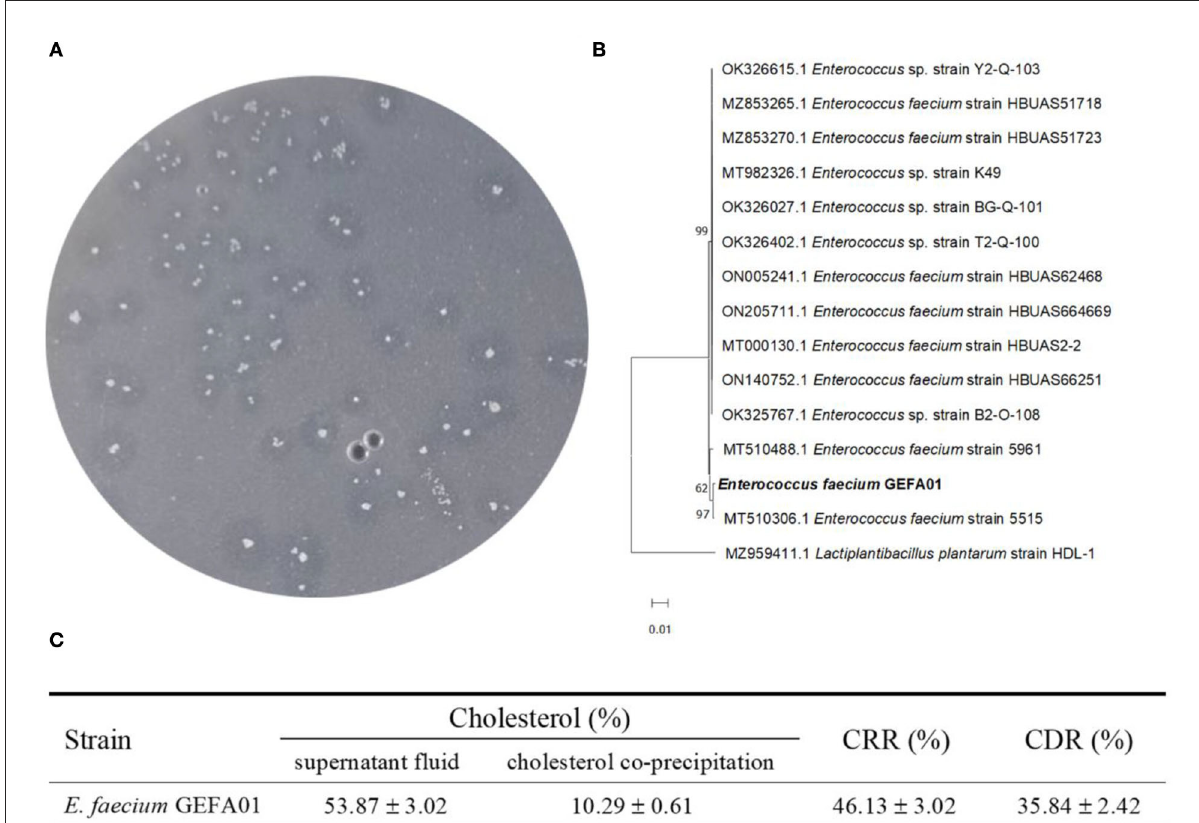
FIGURE1 Study on the cholesterol-lowering mechanism of Enterococcus faecium GEFA01 in vitro . (A) Cholesterol-lowering strains were screened and verified by a selecting medium; (B) The phylogenetic analysis of E. faecium GEFA01; (C) The total content of cholesterol (%) in supernatant fluid and cholesterol coprecipitation (including cell-free supernatant and fragmentized cell solution) of GEFA01. Tests were performed in